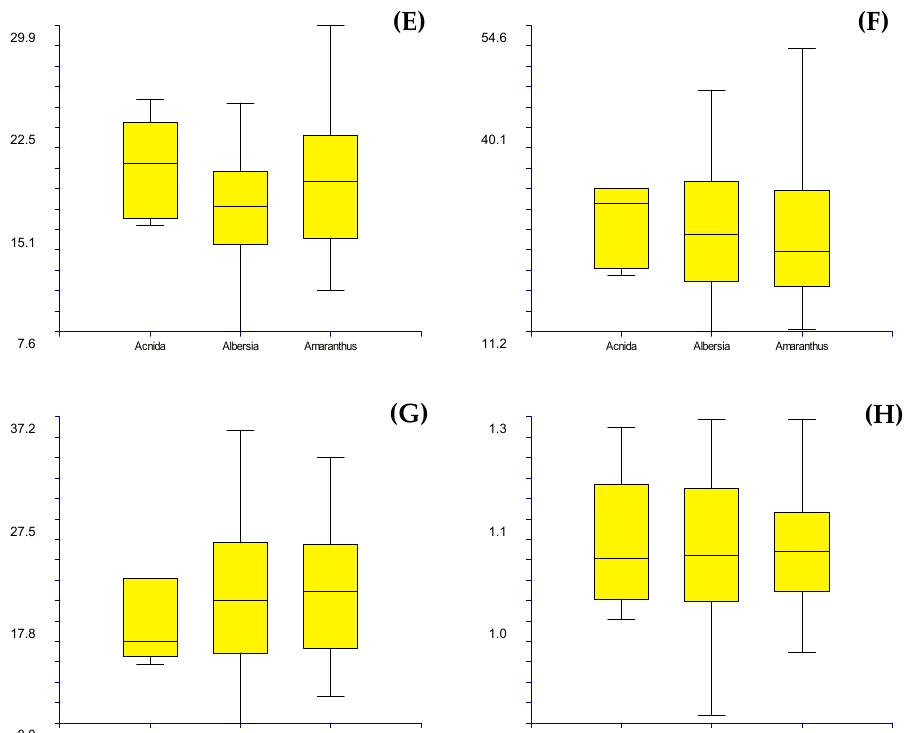
Figure 9. Box plots illustrating the variability of the quantitative micromorphological seeds charac- teristics ( y -axes) per subgenera ( x -axes): length of the flat border ( A ), length of the seed ( B ), width of the seed ( C ), the average length of the peripheral cells ( D ), the average width of the peripheral cells ( E ), the average length of the central cells ( F ), the average width of the central cells ( G ), ratio length/width of the seeds ( H ). Measurements are in µm.